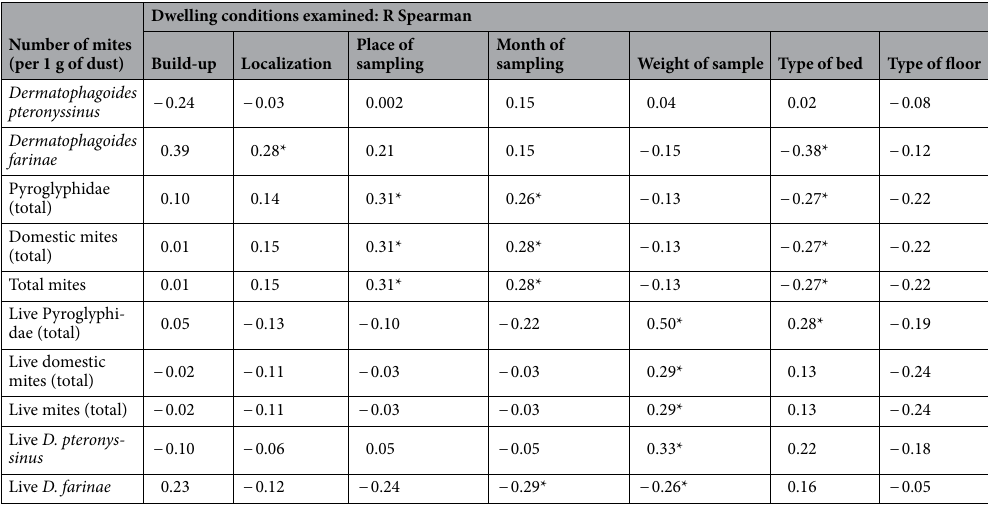
Table 4. Relationships observed between housing conditions and the prevalence of mites in dust samples from dwellings of the examined patients in Bytom (south Poland). Results of the Spearman’s rank correlation test analysis (*p < 0.05). Part II. Type of building: compact [1], free standing [2]; Locality: urban [1], suburban [2]; Place of sampling: walls [0], kitchen floor [1], living-room floor [2], bedroom floor [3], upholstery furniture [4], beds [5], beddings [6]; Month of sampling: 1–12; Weight of sample: in grams; Type of bed: couch [1], sofa [2], bed (mattress) [3]; Type of floor: PVC [1], wooden [2], carpeted